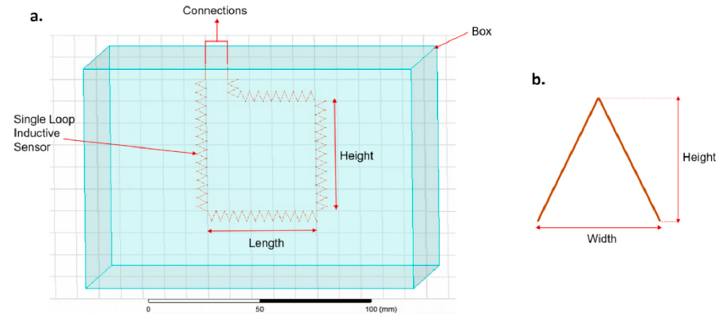
Figure 1. Zigzag pattern evaluation in Ansys. ( a ) Single loop inductive textile sensor; ( b ) definition of zigzag characteristics.